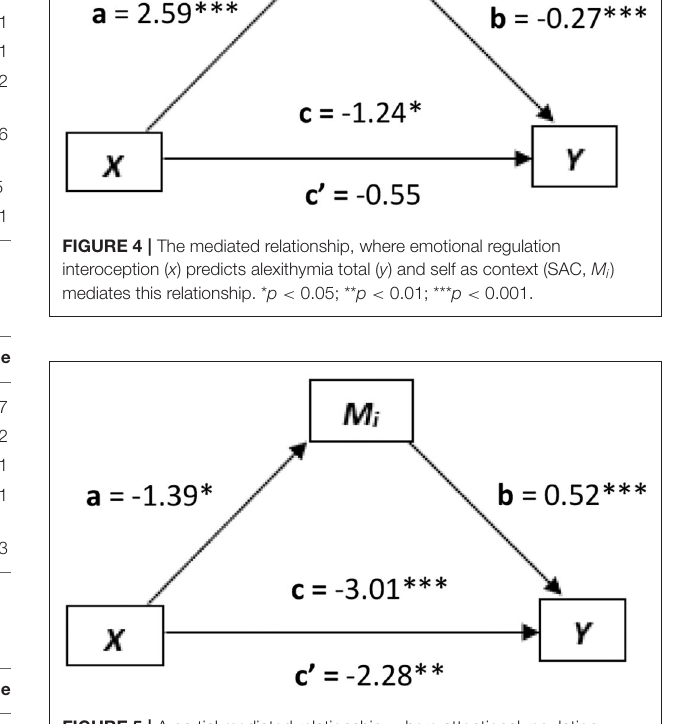
FIGURE 5 | A partial mediated relationship, where attentional regulation interoception ( x ) predicts alexithymia total ( y ), and psychological flexibility (AAQ-II, M i ) partially mediates this relationship. * p < 0.05; ** p < 0.01; *** p <